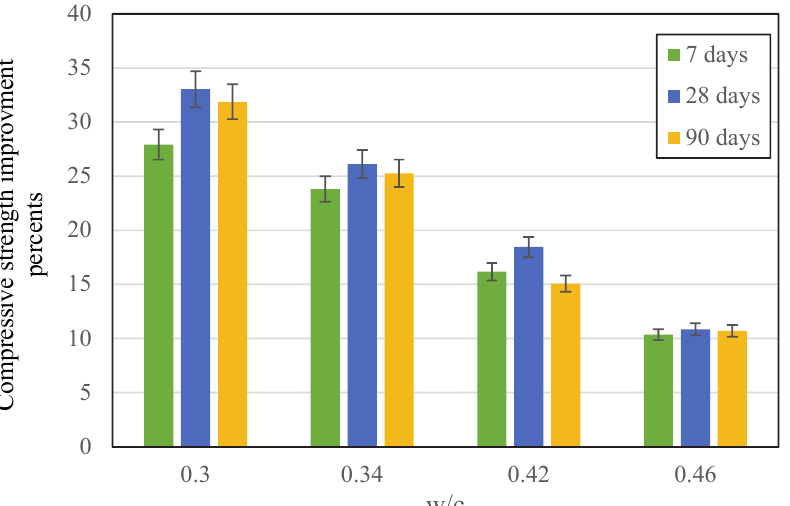
Figure 9: Compressive strength improvement after 7, 28 and 90